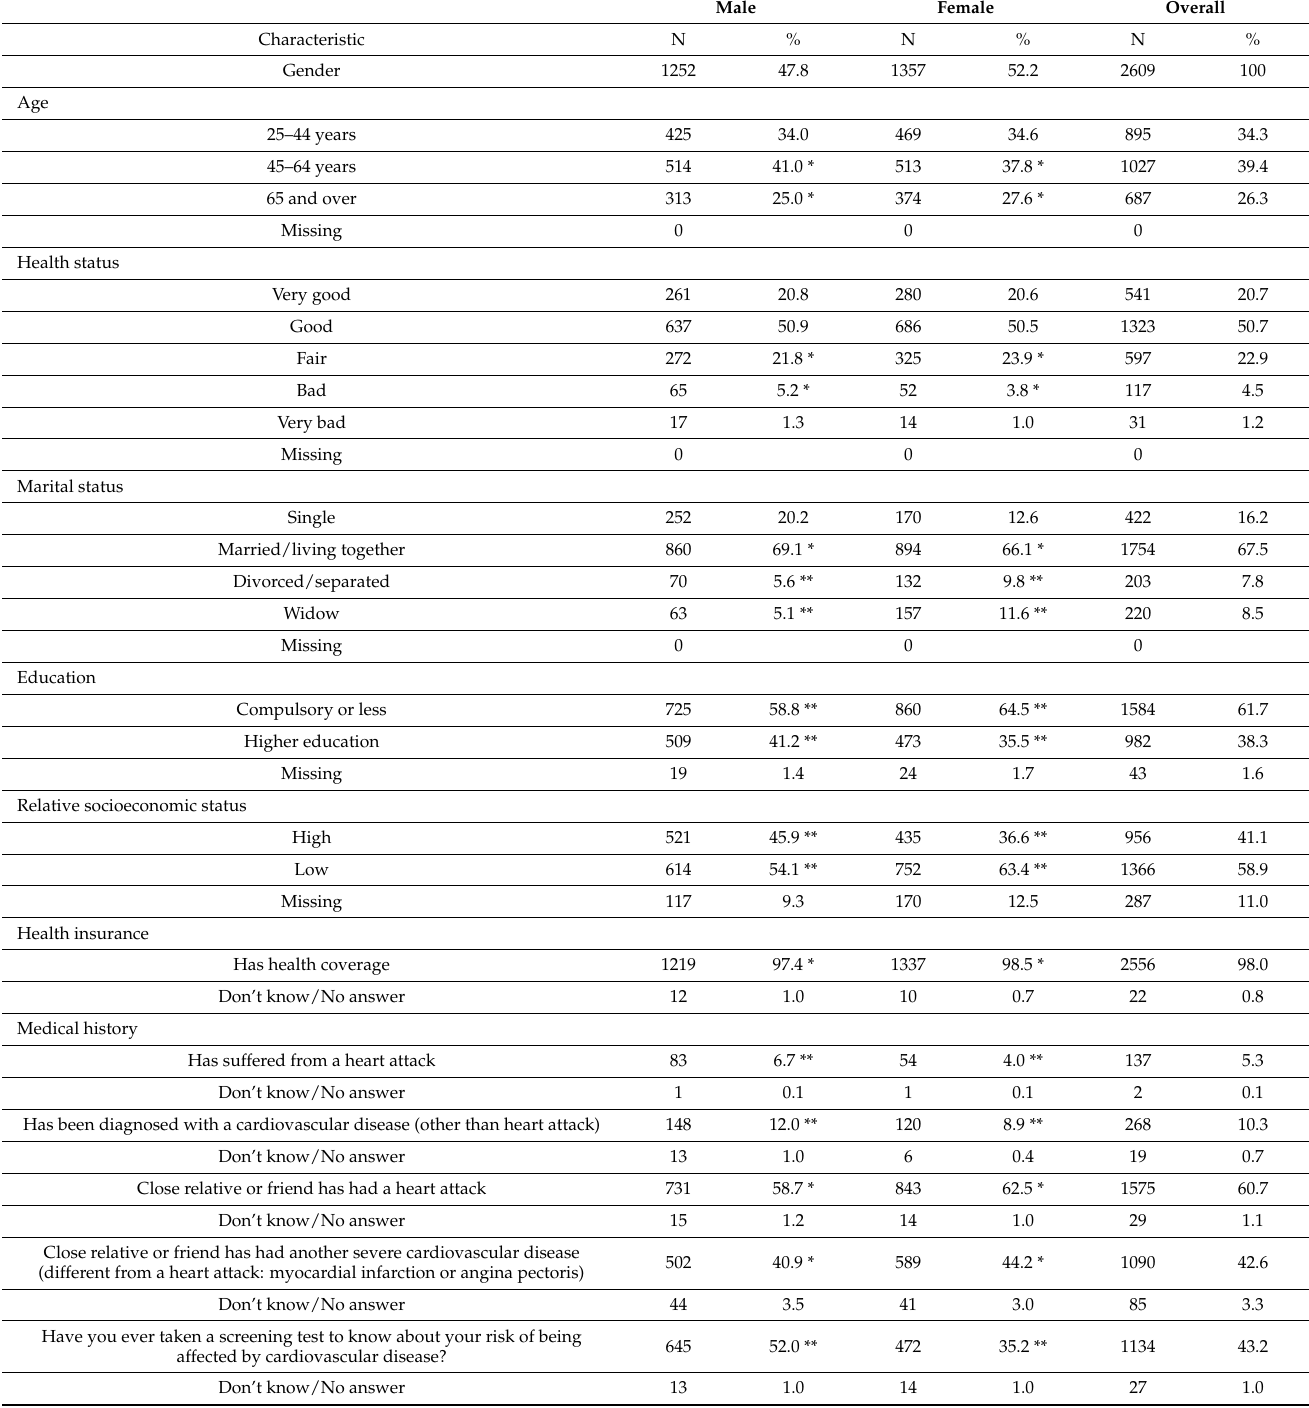
Table 1. Demographic characteristics of respondents to the CAD awareness survey, according to